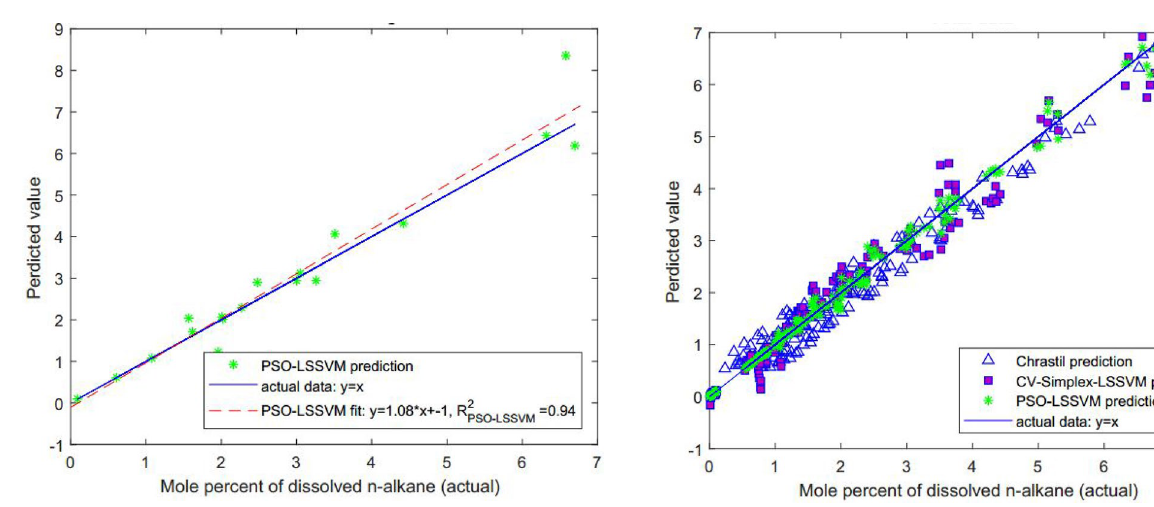
Fig. 6 Predicted mole percent of dissolved n -alkane by Chrastil, CV- Simplex and PSO–LSSVM models versus actual